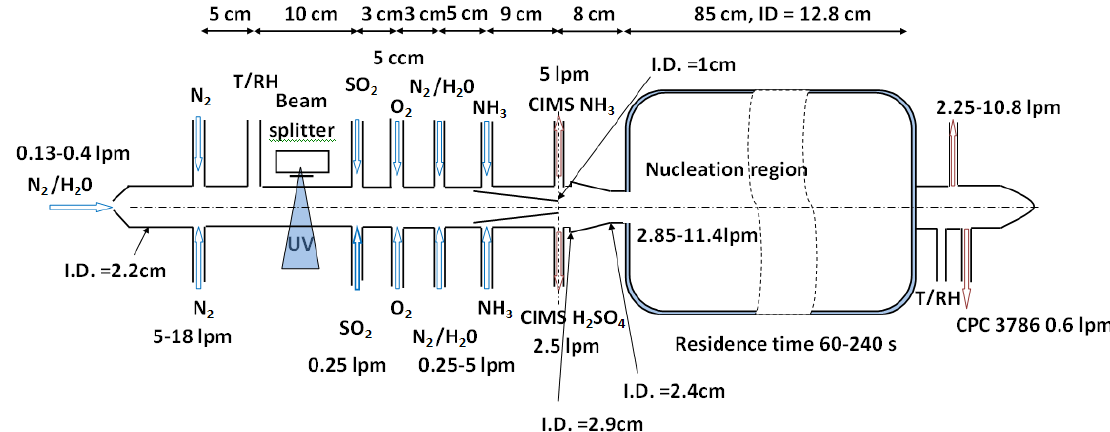
Fig. 1. A flow reactor used in KSU aerosol nucleation setup. All [H 2 SO 4 ] and [NH 3 ] reported in this study were measured at the entrance of the nucleation reactor. Trimethylamine was also measured with CMS based on a similar ion chemistry used in NH 3 measurements (Erupe et al., 2011). For wall loss studies, we used two CIMSs at the entrance and the end of the nucleation reactor, to simultaneously measure H 2 SO 4